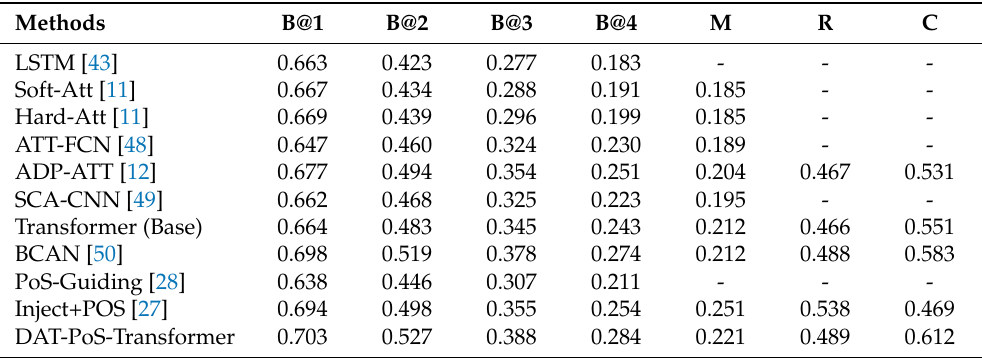
Table 6. Comparison of image captioning performance with state-of-the-art methods on Flickr30k caption dataset under cross-entropy